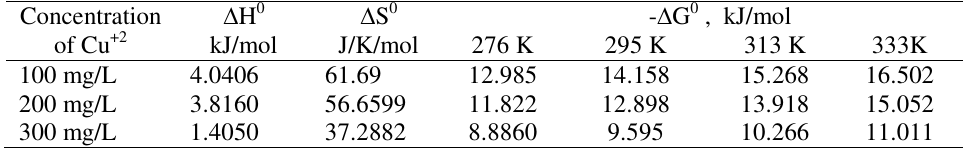
Table 3. Thermodynamic parameters for the sorption of Cu +2 on